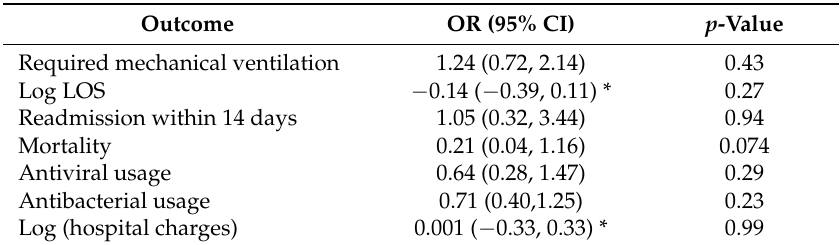
Table 3. Multivariate analysis evaluating clinical course and management of children who tested positive with RVPP versus SV testing, excluding HRV and